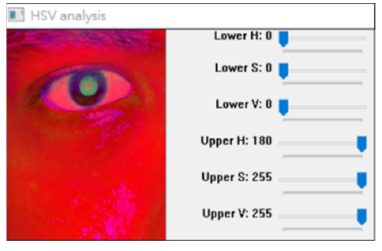
Figure 33. Original RGB image and corresponding image obtained after HSV color conversion.